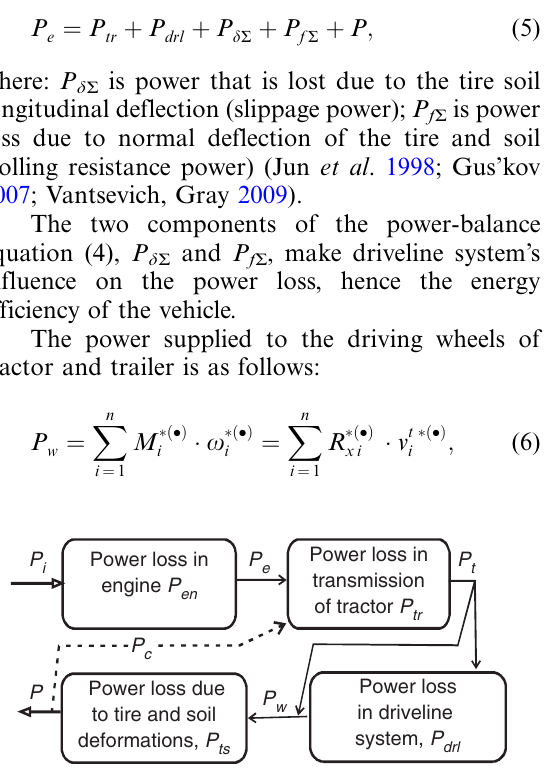
Fig. 2. Flowchart of power transference and losses when the wheels of tractor and trailer are